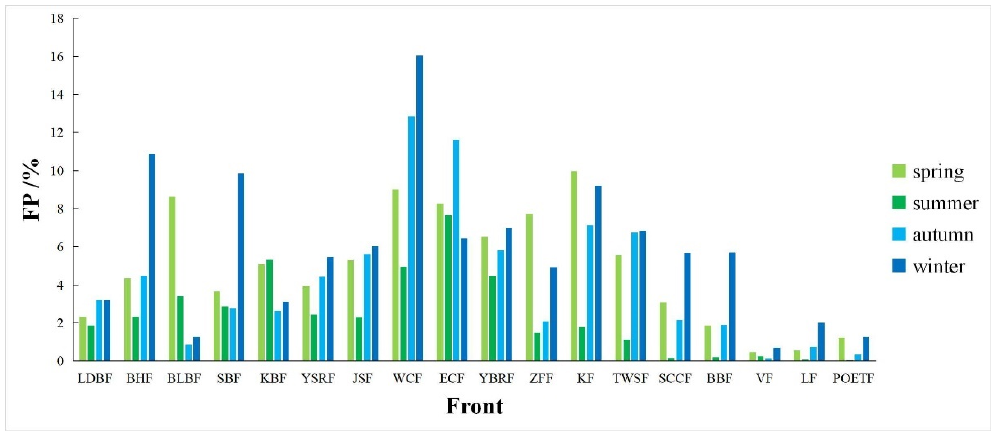
Figure 5. Histogram of frontal frequency of 18 fronts in different seasons.